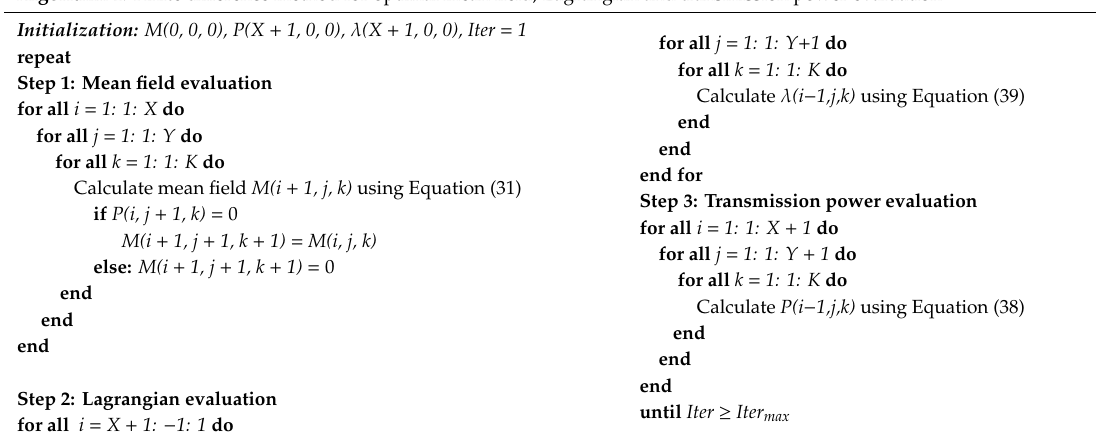
algorithm to obtain an optimal power control policy by evaluating against di ff erent available policies and finding the power level for each policy. Algorithm 1: Finite di ff erence method for optimal mean field, Lagrangian and transmission power evaluation Initialization: M(0, 0, 0), P(X + 1, 0, 0), λ (X + 1, 0, 0), Iter =